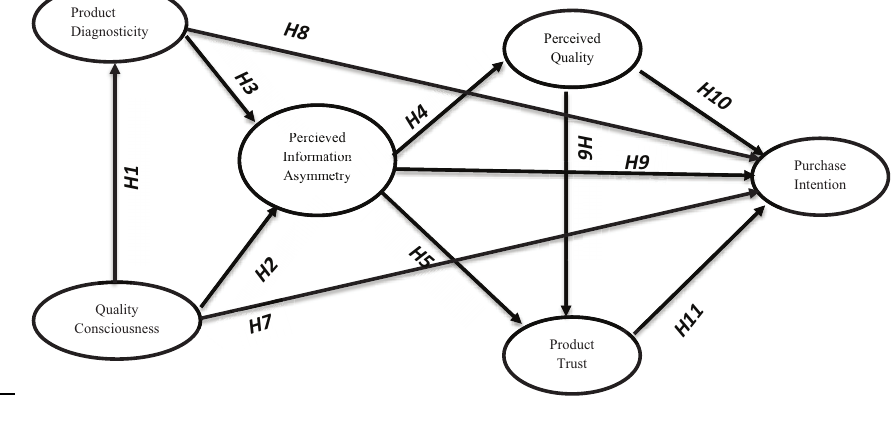
Figure 1. Research